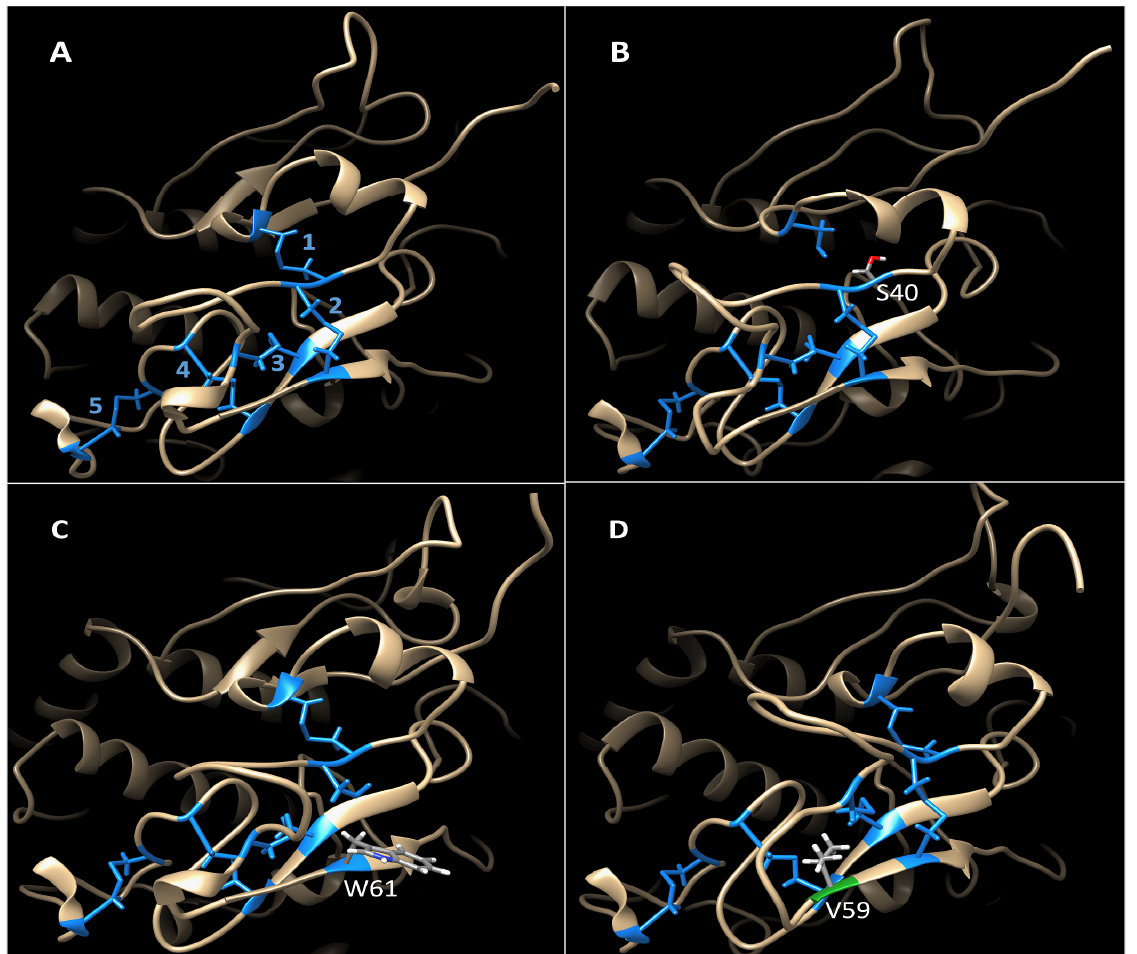
Figure 6. Cys-rich domains of Tyrp2 and mutant variants. ( A ) Tyrp2 structure at 50 ns with numbered disulfide bridges. ( B ) C40S mutant variant at 50 ns. The introduction of serine at position 40 prevented the formation of disulfide bridge 1. ( C ) C61W mutant variant at 50 ns. The introduction of tryptophan at position 61 prevented the formation of disulfide bridge 2. ( D ) G59V mutant variant at 50 ns. Mutation to valine at position 59 (green) did not alter the formation of disulfide bridges in the structure.